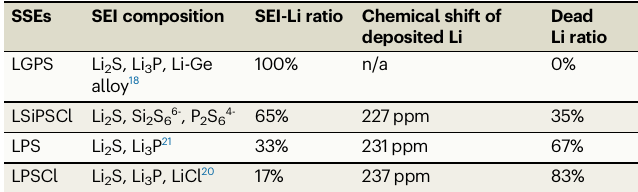
Table 1 | Summary of SEI compositions, chemical shifts of deposited lithium and the relative ratio of total accumulated SEI-Li/dead Li, in four different